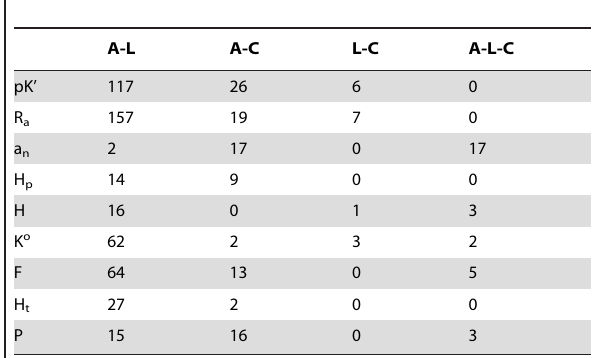
Table 1. Total number of similar amino acid sites between the different groups of sarcopterygians which have been affected by positive-destabilizing during